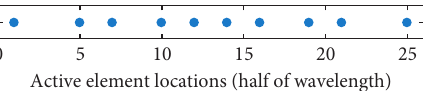
Figure 4: Type 2 array configuration.